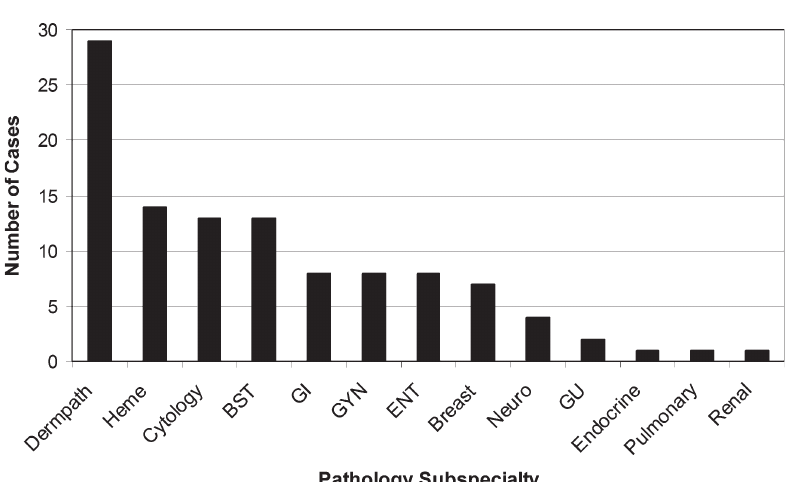
Fig. 1. Number of cases posted by pathology subspecialty. More than 60% of cases were posted in four subspecialty areas: dermatopathology (Dermpath), hematopathology (Heme), cytology, and bone and soft tissue (BST) pathology. Additional abbreviations: GI – gastrointestinal; GYN – gynecologic; ENT – ear, nose and throat; Neuro – neuropathology; GU – genitourinary.